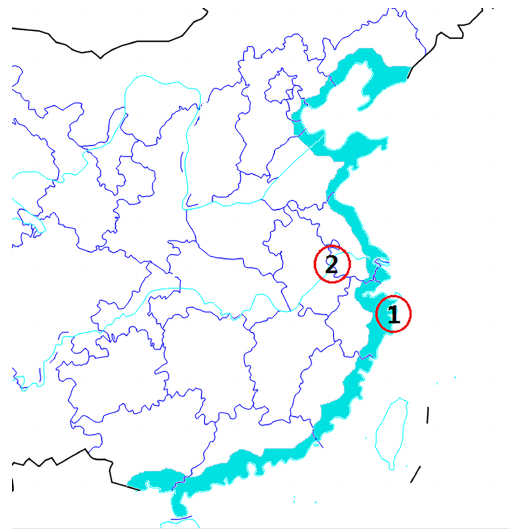
Figure 1. Locations of two sampling sites: (1) the coastal site at Xiangshan gulf and (2) the inland urban site that is 200km from the coast. The blue color indicates the coastal area of the Chinese